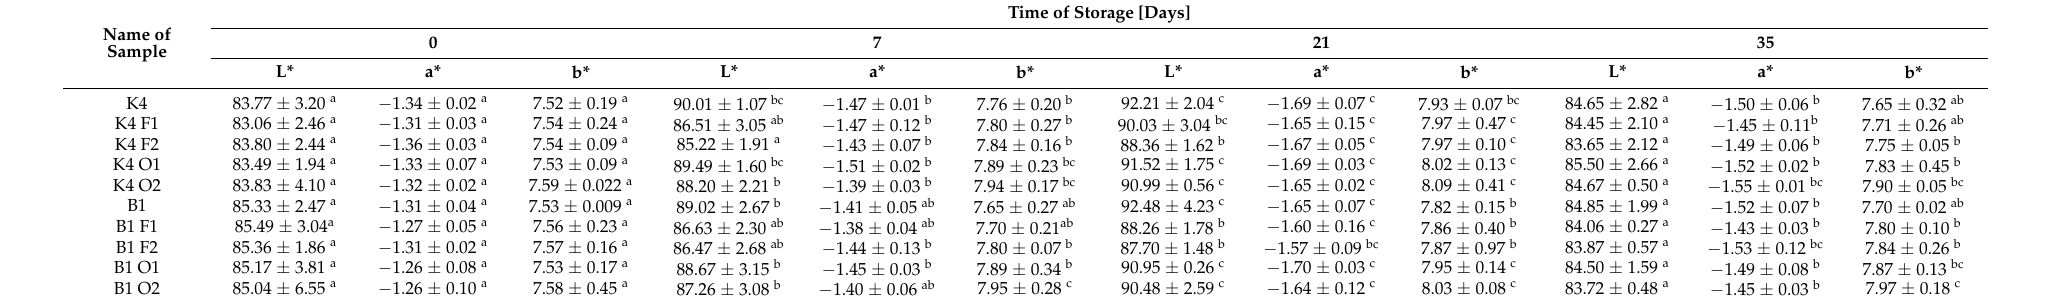
Table 4. Changes in color values (L* a* b*) in fermented milk samples during